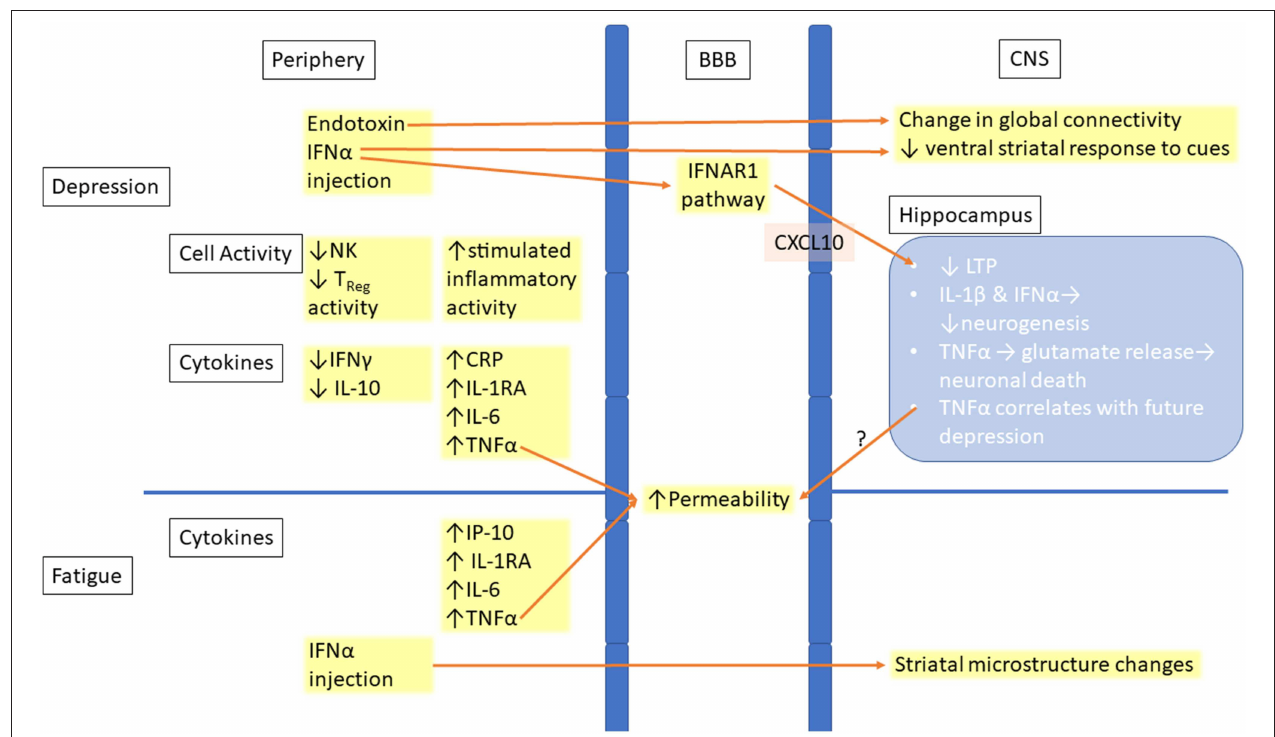
FIGURE 1 | Links between peripheral inflammation and changes in the CNS in depression and fatigue. Increased inflammation is seen in the periphery in both depression and fatigue. This inflammation leads to increased permeability of the BBB, allowing for easier entry of inflammatory molecules or immune cells into the CNS. Inflammatory signaling in the CNS leads to both structural and functional changes, with the hippocampus being the location of many of the changes. BBB, Blood–brain barrier; CNS, Central nervous system; CRP, C-reactive protein; IFN, Interferon; IFNAR1, Interferon-alpha/beta receptor alpha chain; IL, Interleukin; IP-10, Interferon gamma-induced protein 10; TNF, Tumor necrosis factor; NK, Natural killer cell; T reg , Regulatory T cell; LTP, Long-term potentiation.